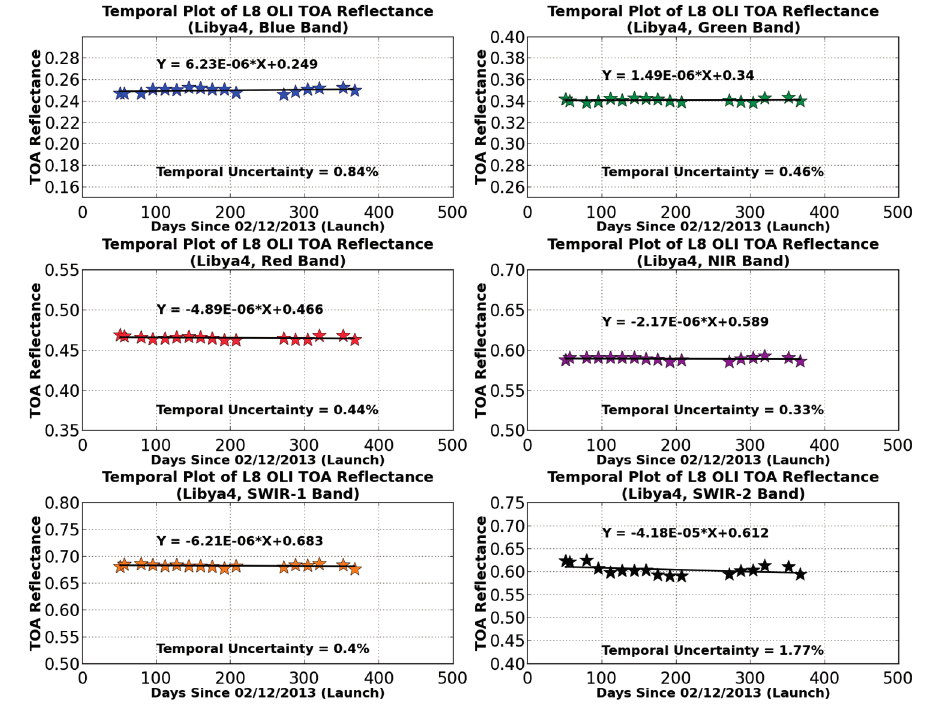
Figure 7. Temporal Trend of L8 OLI over Libya 4 PICS.